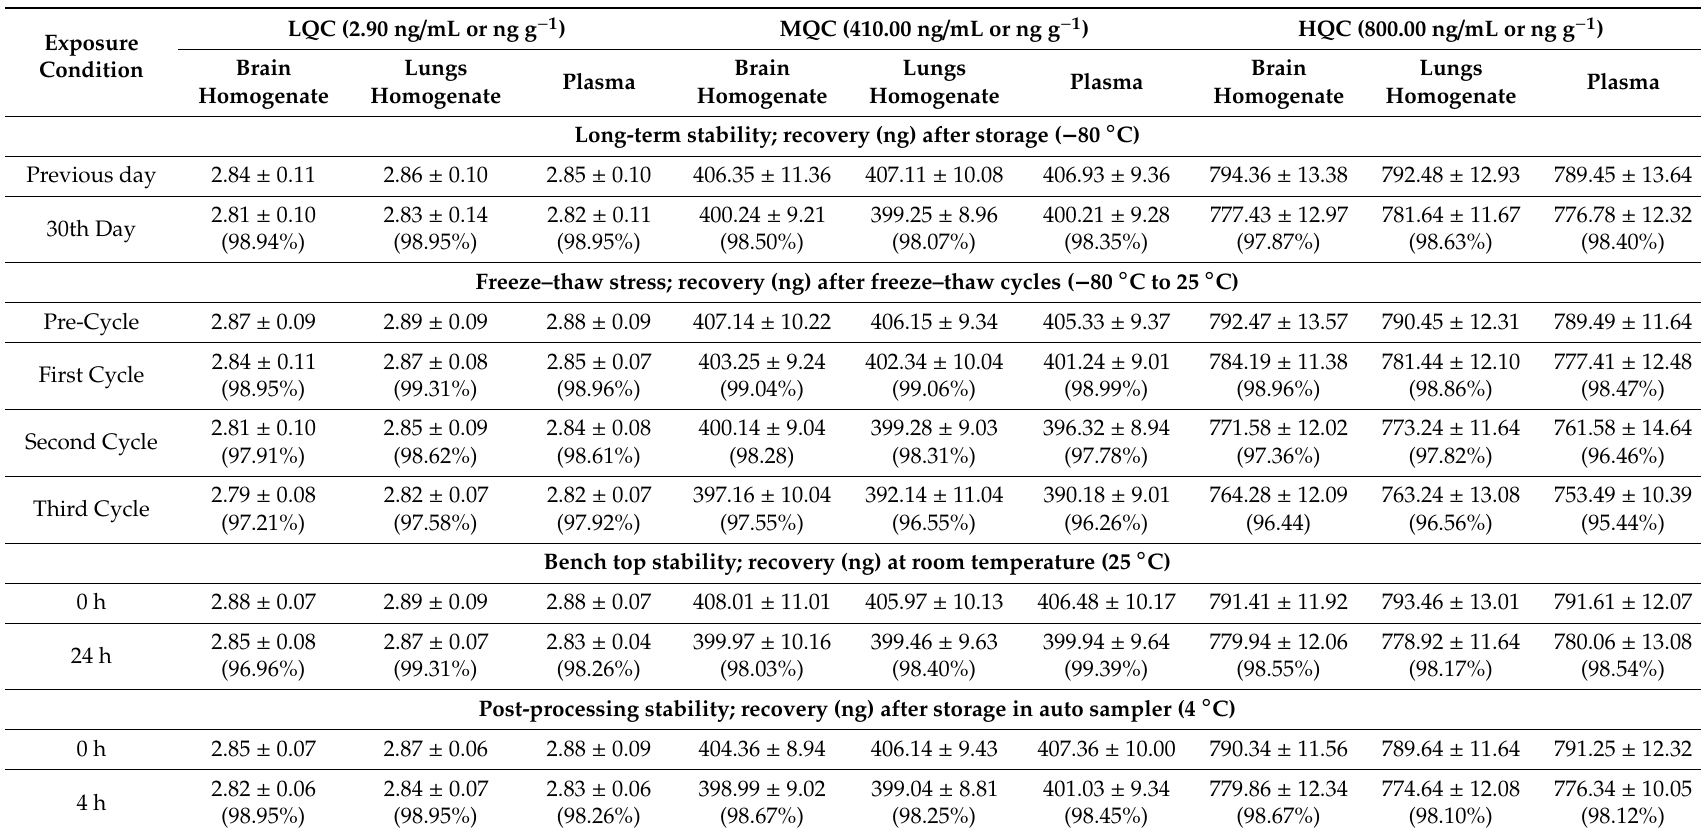
Table 7. Validation: stability data for catechin hydrate (CH) in di ff erent